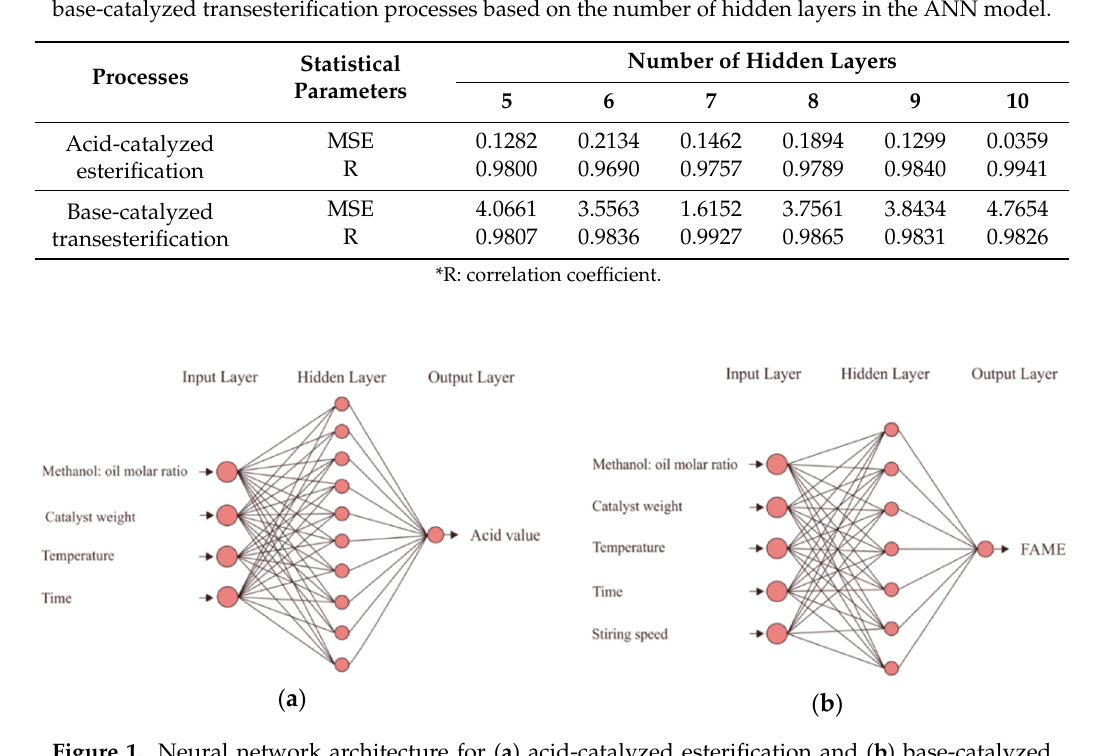
Figure 1. Neural network architecture for ( a ) acid-catalyzed esterification and ( b ) base-catalyzed